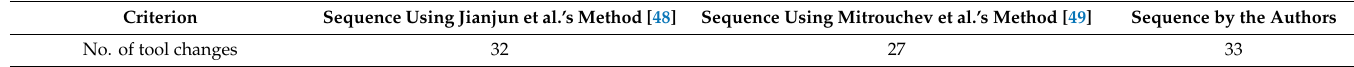
Table 5. Number of tool changes during the three